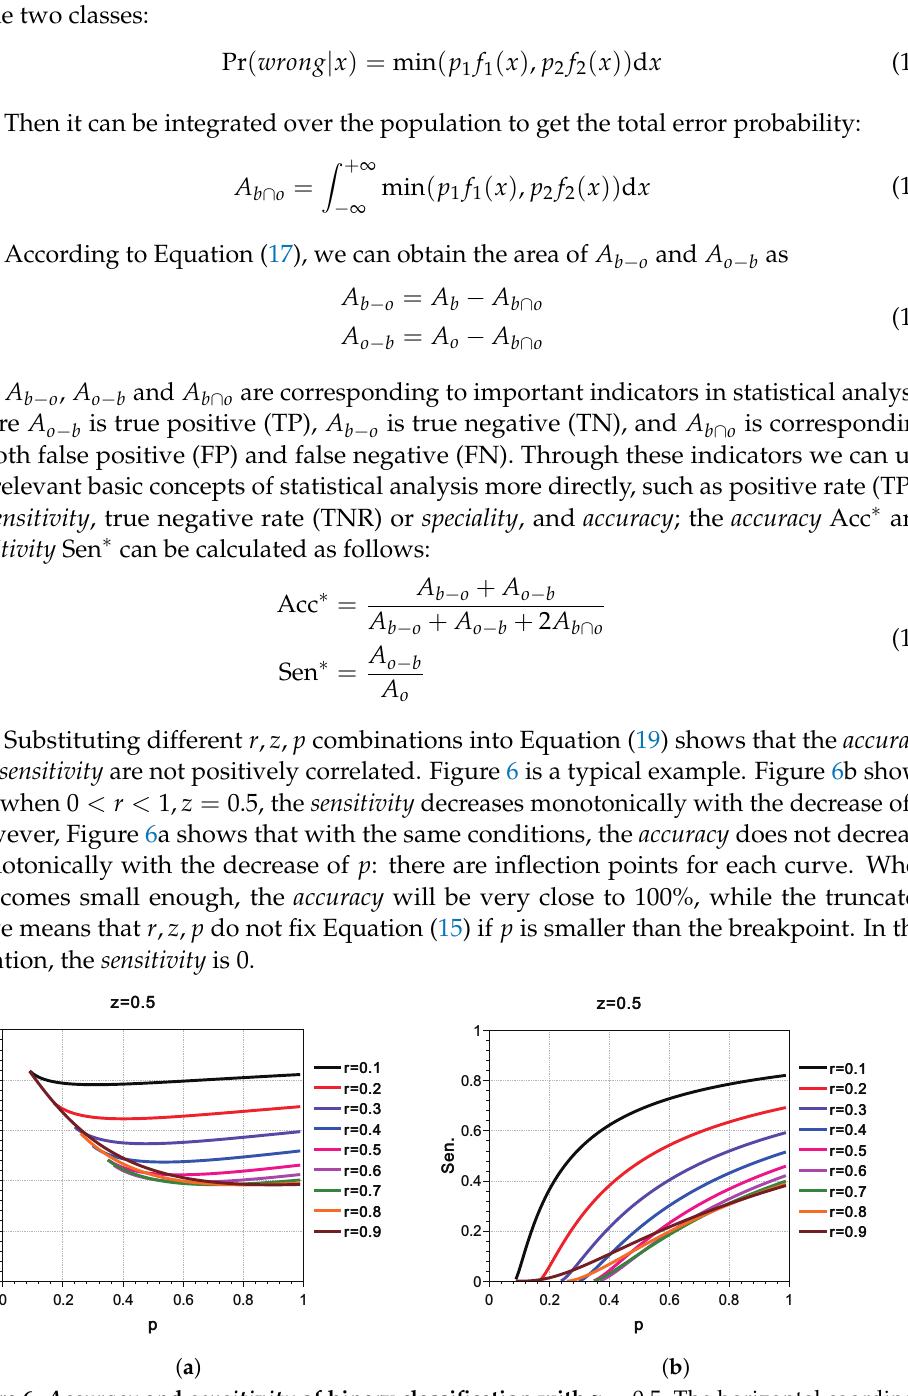
Figure 6. Accuracy and sensitivity of binary classification with z = 0.5 . The horizontal coordinate axis is p , while the vertical coordinate axis is the value of accuracy and sensitivity . The curves represented by different r values are distinguished by different colors. ( a ) Accuracy. ( b )